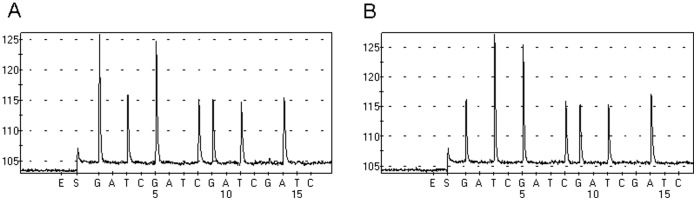
PNA-PCR assay could suppress wild-type DNA more completely in the existence of KRAS mutant DNA.(A) There are wild-type PCR products when adding 100 ng KRAS wild-type DNA in PNA-PCR assay. (B) There are only KRAS mutant PCR products when adding 100 ng wild-type DNA and 0.01 ng KRAS mutant DNA.